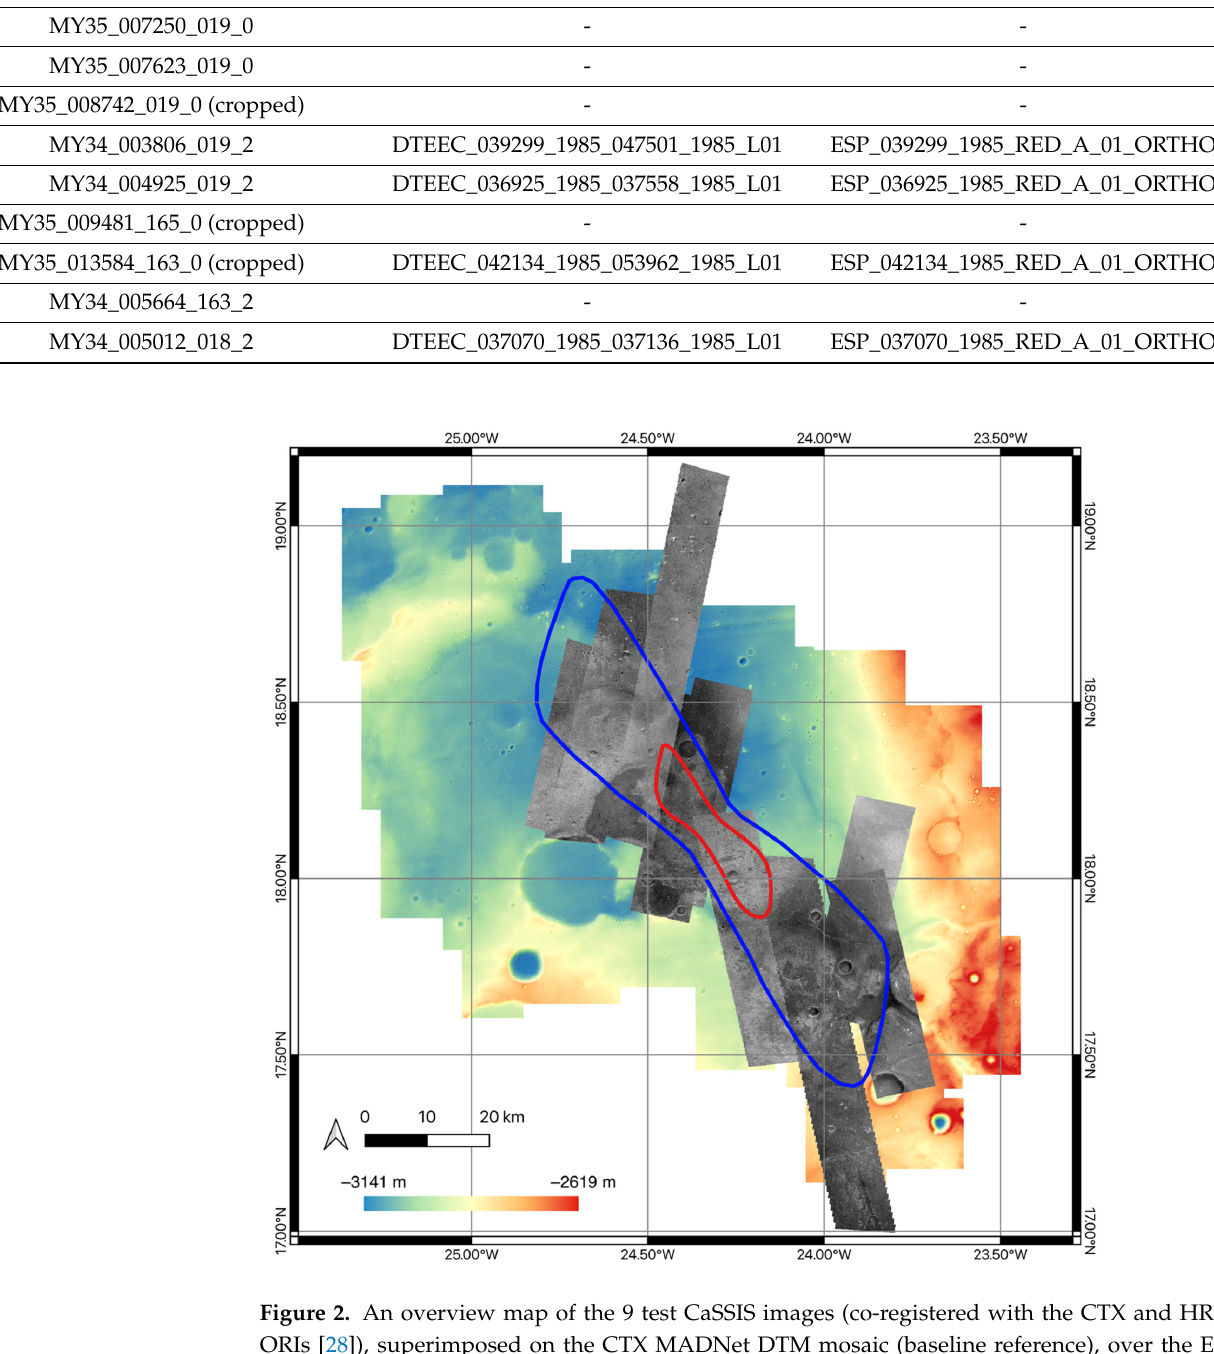
Table 1. Lists of the input CaSSIS images (in the order of the image co-registration process–reverse order of the image and DTM mosaicing process), validation HiRISE PDS DTMs, and the correspond- ing HiRISE PDS ORIs, over the 3-sigma ellipses of the ExoMars Rosalind Franklin rover’s landing site at Oxia Planum.